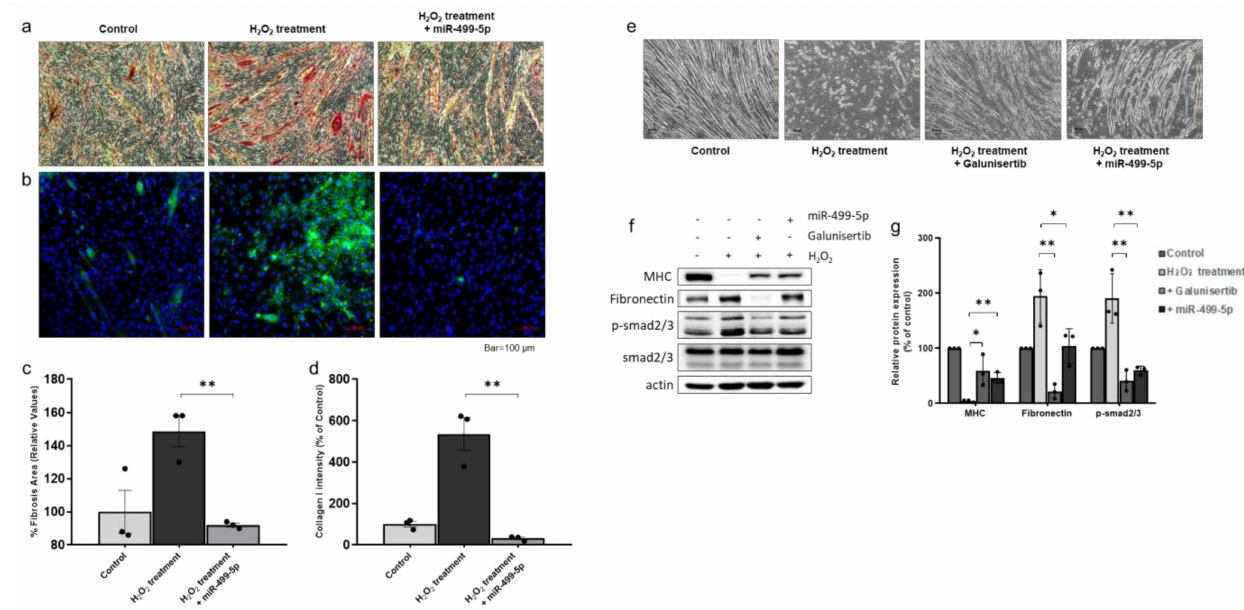
Figure 6. Effects of miR-499-5p on an H 2 O 2 -induced myotube fibrosis model ( a , c ) Fibrosis was assessed as the percentage of the area positive for Sirius Red staining. Quantitative measurements were performed in ImageJ, and data are expressed as the mean ± SEM. Bars with different superscripts indicate significantly different values (** p < 0.01). Scale bars: 100 µ m. ( b , d ) Immunocytochemistry to detect collagen I deposition in myotubes. Quantitative measurements were performed in ImageJ, and data are expressed as mean ± SEM. Bars with different superscripts indicate significantly different values (** p < 0.01). Scale bars: 100 µ m. ( e ) Differentiated myotubes were treated with 2 mM H 2 O 2 in the absence or presence of galunisertib and miR-499-5p mimic. Administration of galunisertib and miR-499-5p mimic induced recovery of myotubes damaged by H 2 O 2 treatment (bar = 100 µ m). ( f ) Representative western blots for myosin heavy chain, fibronectin, and phospho-smad2/3. β -actin was used as a loading control. Phospho-smad2/3 was normalized to total smad2/3. ( g ) Quantification of myosin heavy chain, fibronectin and phospho-smad2/3 protein levels. Data are expressed as the mean ± SEM. Bars with different superscripts indicate significantly different values (* p < 0.05, ** p <